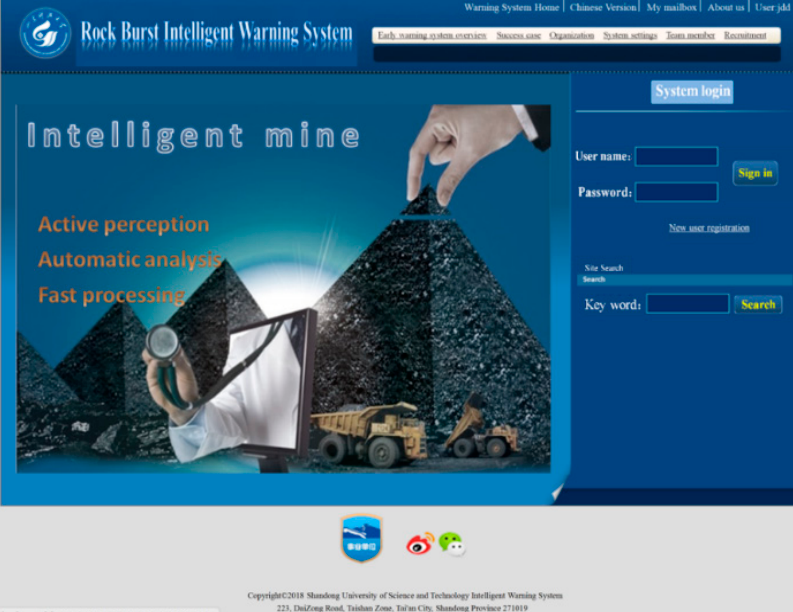
Figure 9. Software startup interface.